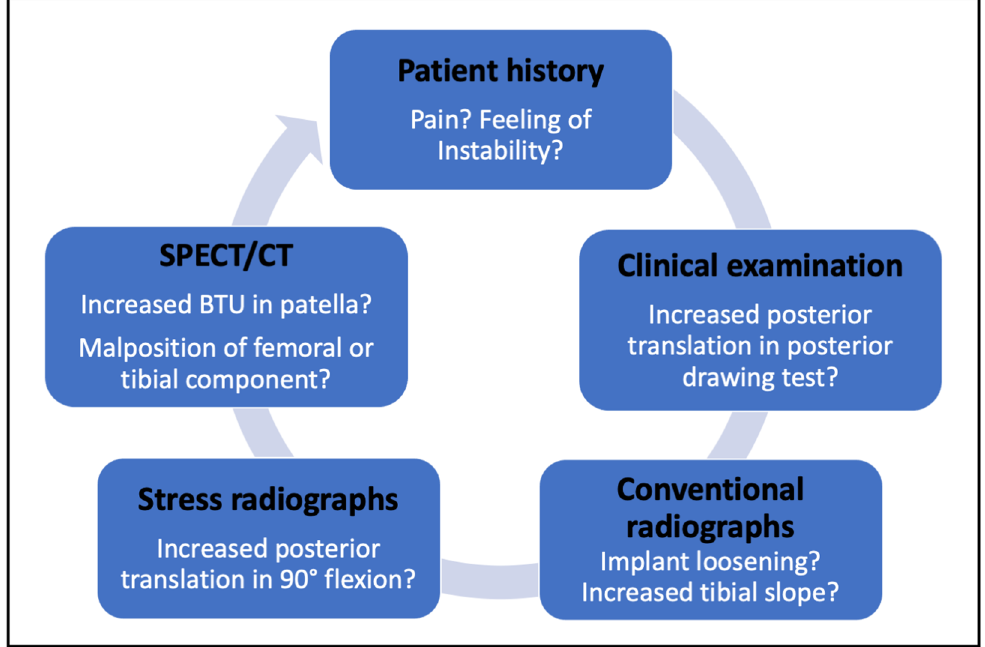
Figure 6. This figure highlights the diagnostic workup for patients with flexion instability after CR TKA proposed by the present case report.